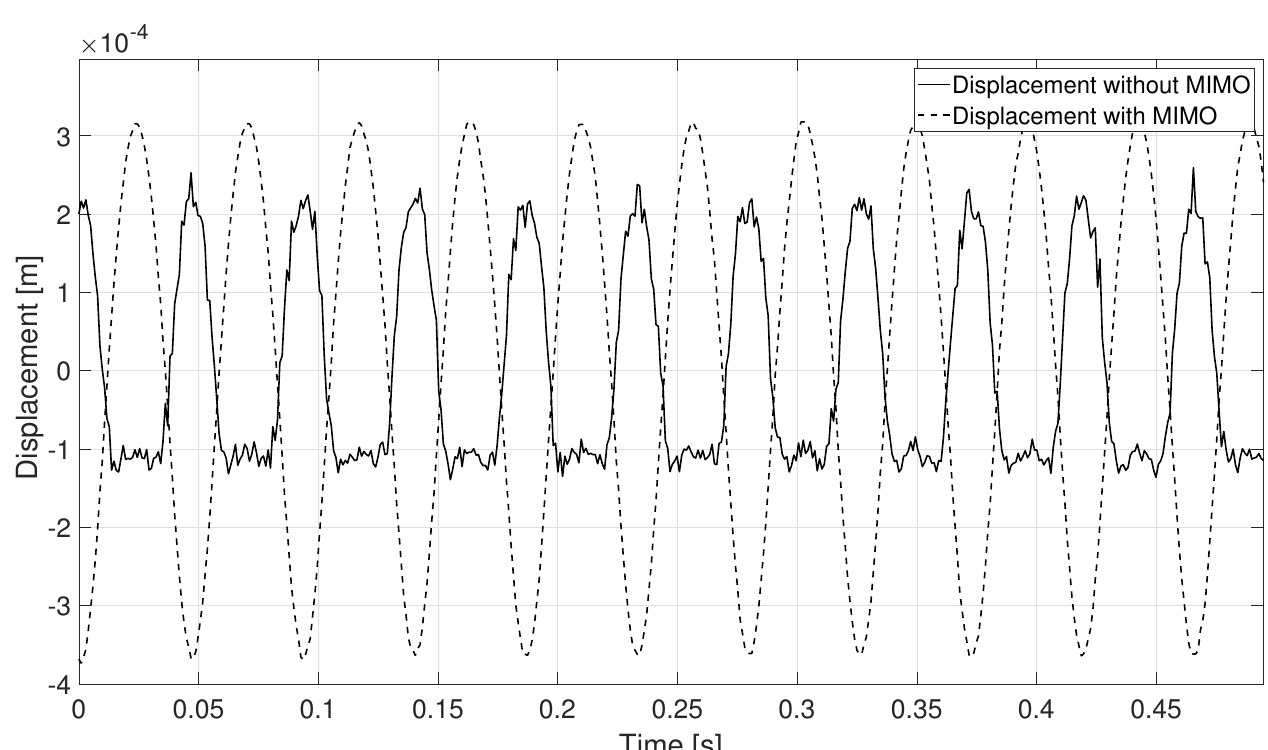
Figure 12. Measurement results for the test 21.5 Hz–0.25 V, when using the angular identification (enabled by MIMO) or